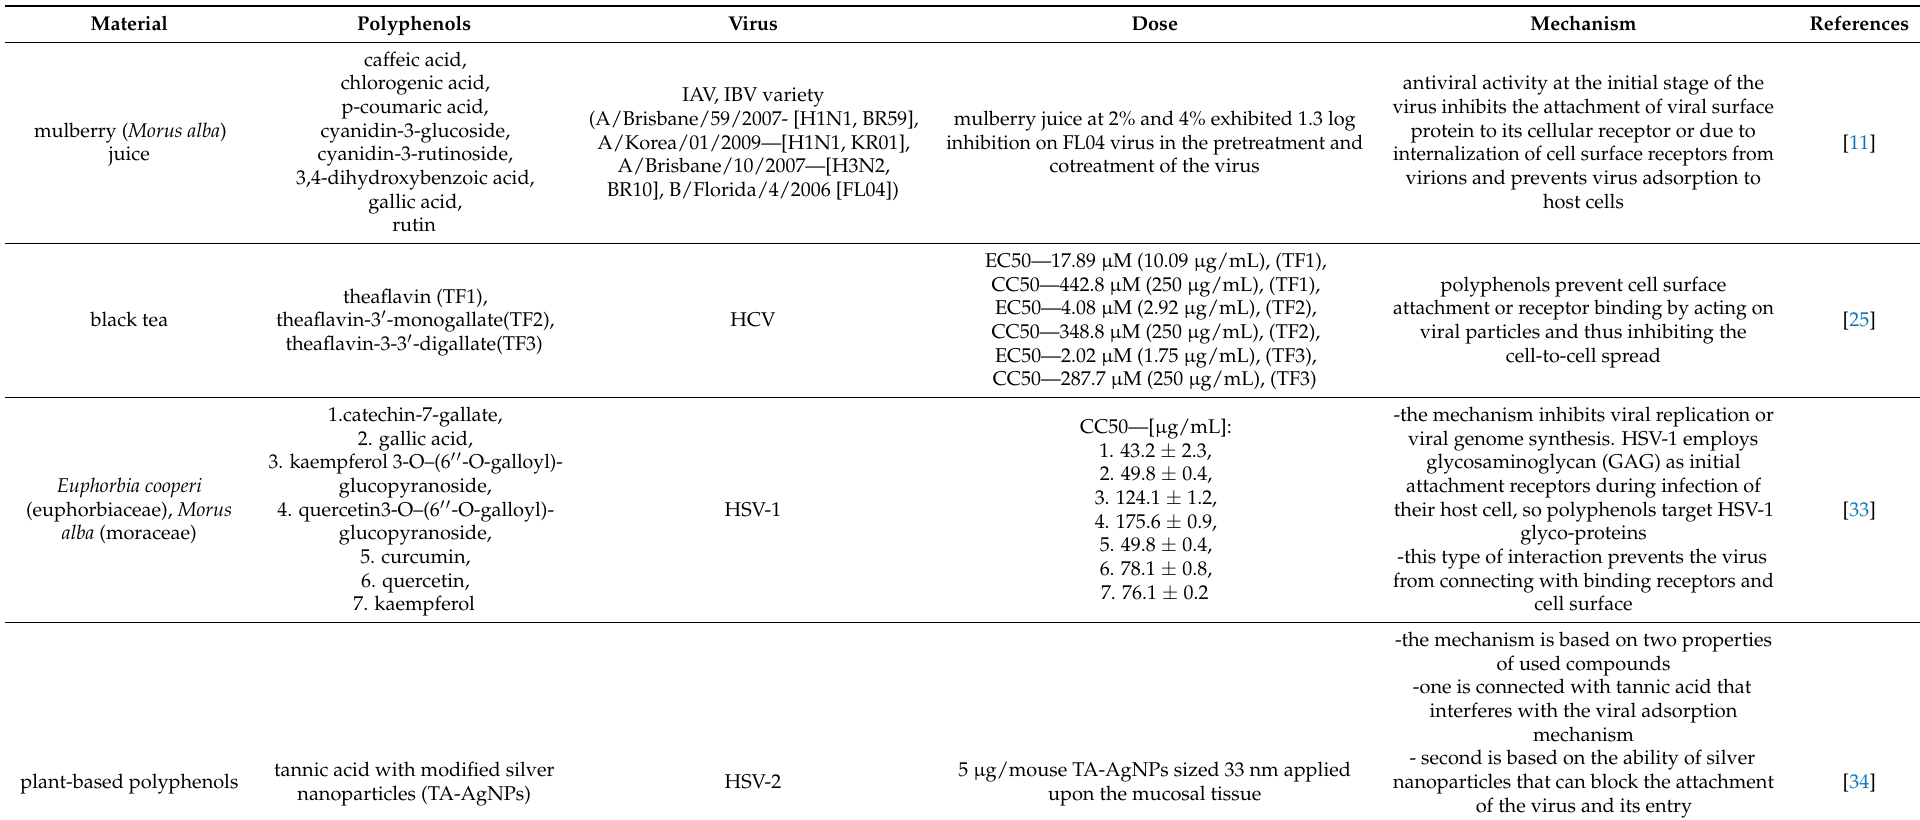
Table 1. Antiviral activity of different polyphenols extracted from